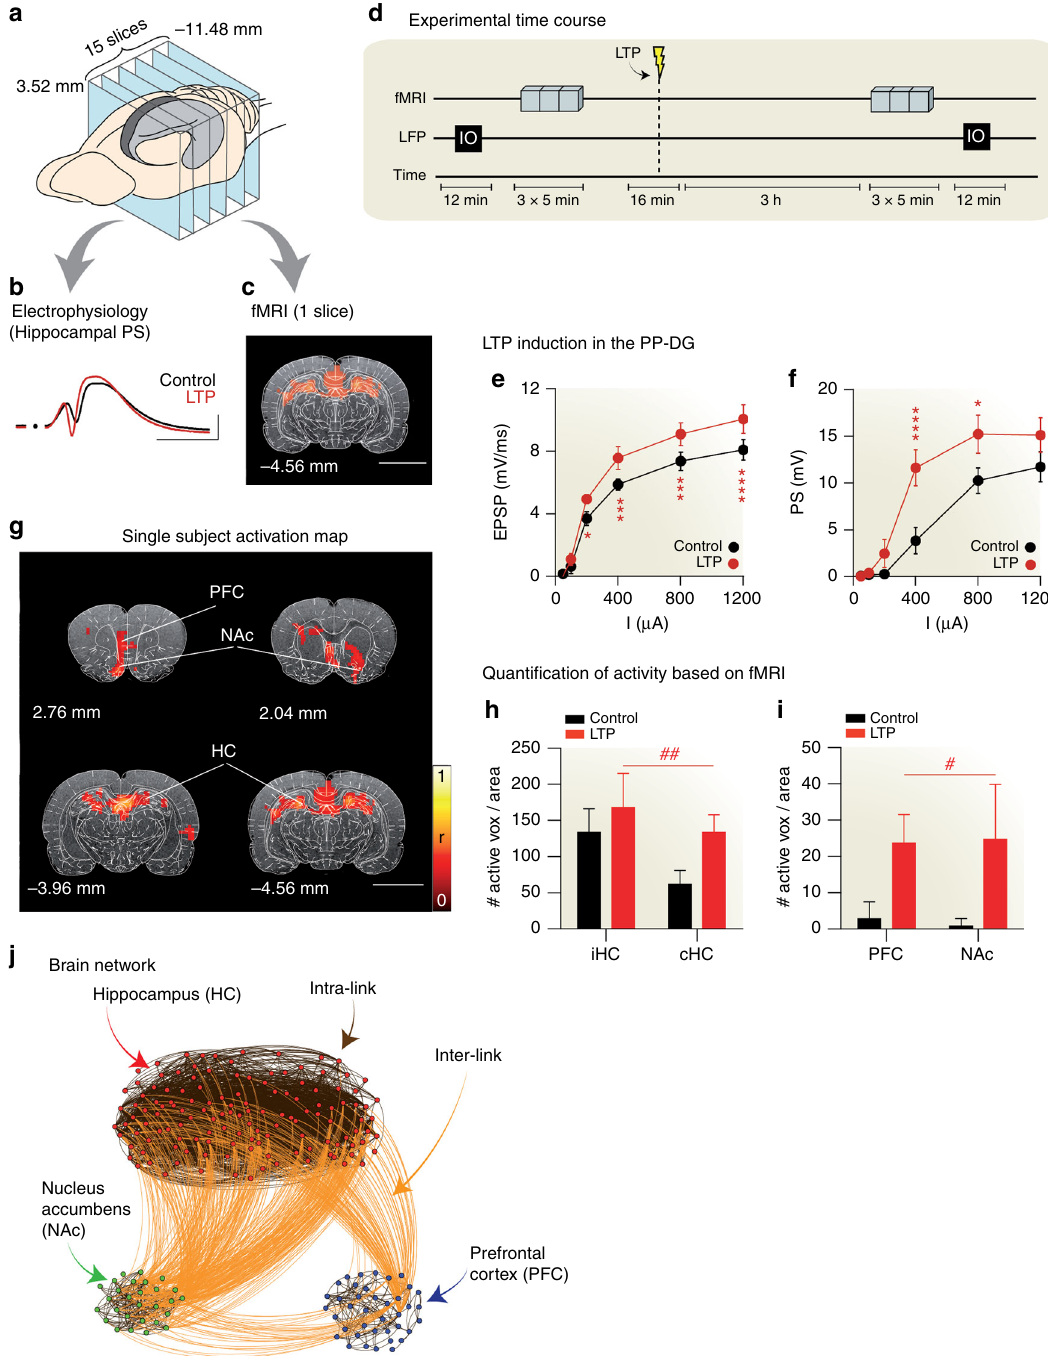
Fig. 1h, i for group results and statistics; see also Supplementary Note 2). Conversely, low-frequency stimulation of the perforant pathway before LTP induction produces no fMRI activity in the PFC nor in the NAc (Fig.